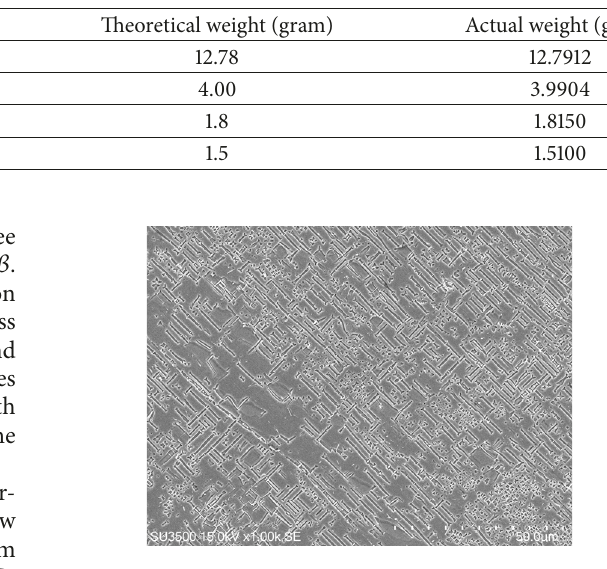
Figure 1: Dispersion of rod-like B2 (Fe,Ni)Al precipitates in the ferrite- 𝛼 matrix of as-homogenized